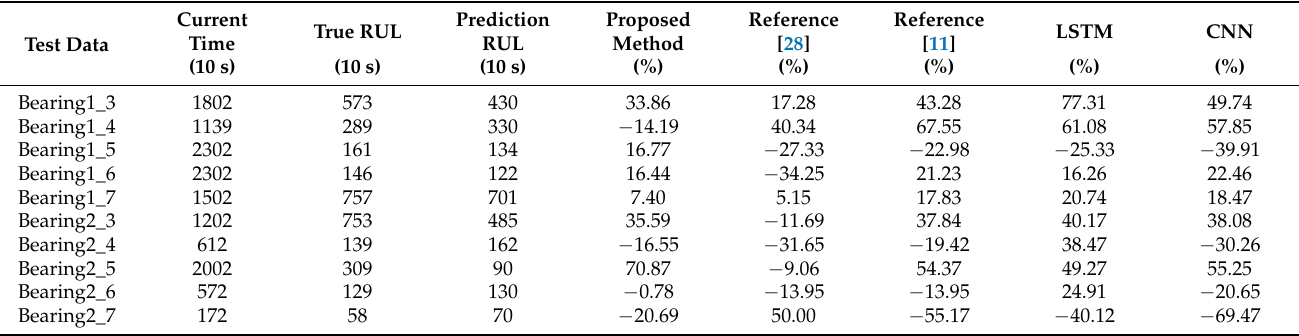
Table 5. Prediction results and comparison of